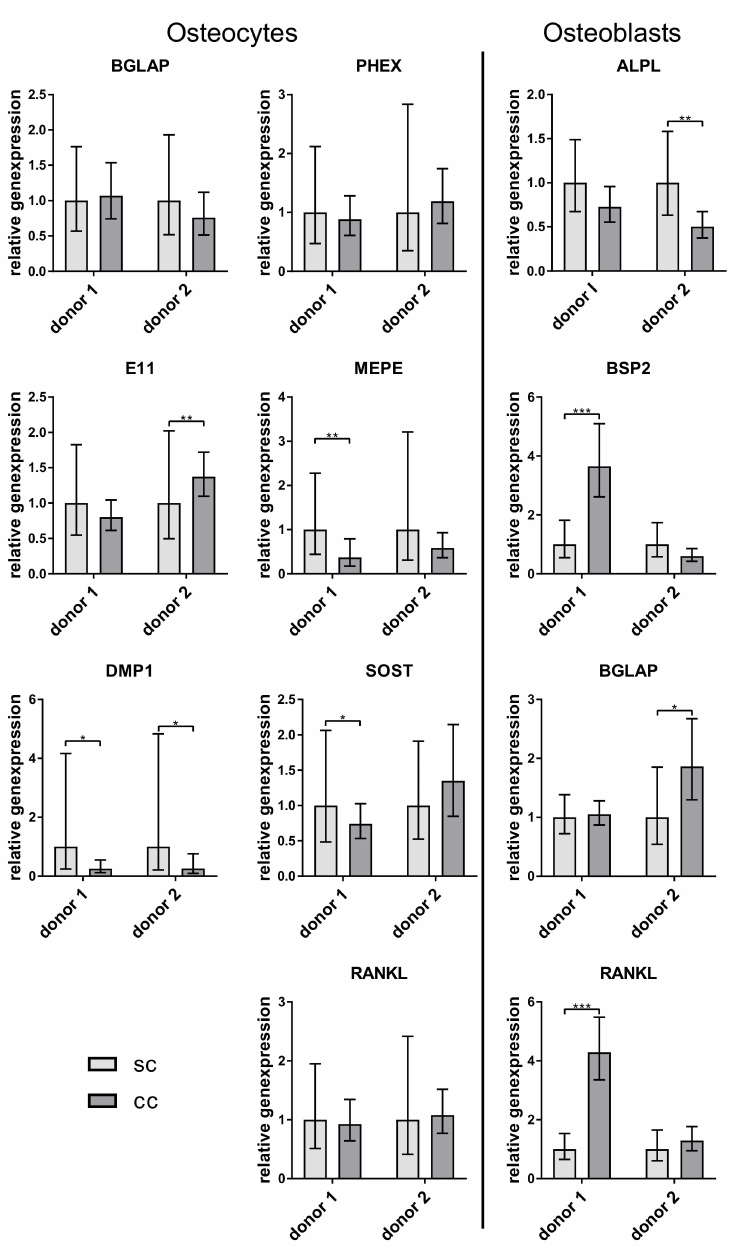
Figure 4. Relative expression of osteocyte and osteoblast markers from single- (sc) and co-cultivated (cc) osteocytes and osteoblasts. Osteocytes were isolated directly from bone (compare Figure 1A). Data from two di ff erent cell donors are presented in one diagram ( n = 3 replicates / donor): mean ± upper / lower limit. Significant di ff erences to the single culture were defined as* p < 0.05, ** p < 0.01, and *** p <